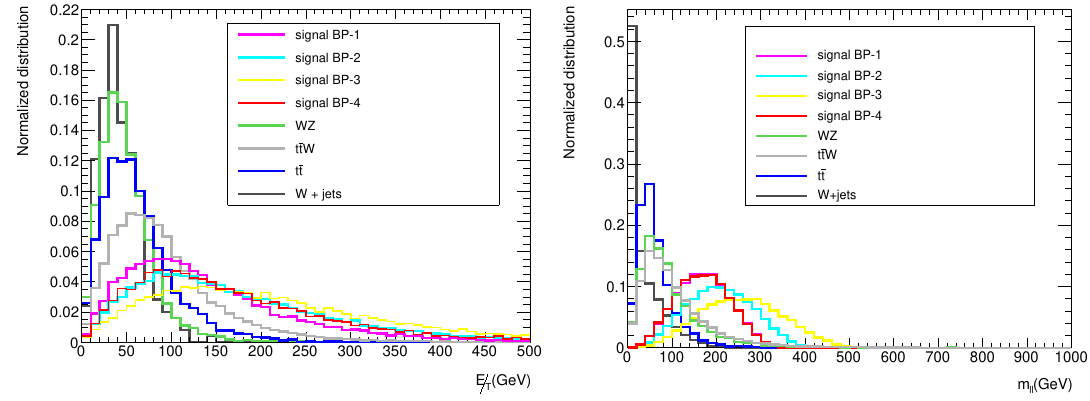
Figure 14 . Distribution of =E T (left) and invariant mass(right) of same-sign dileptons for the four signal BPs and backgrounds in case